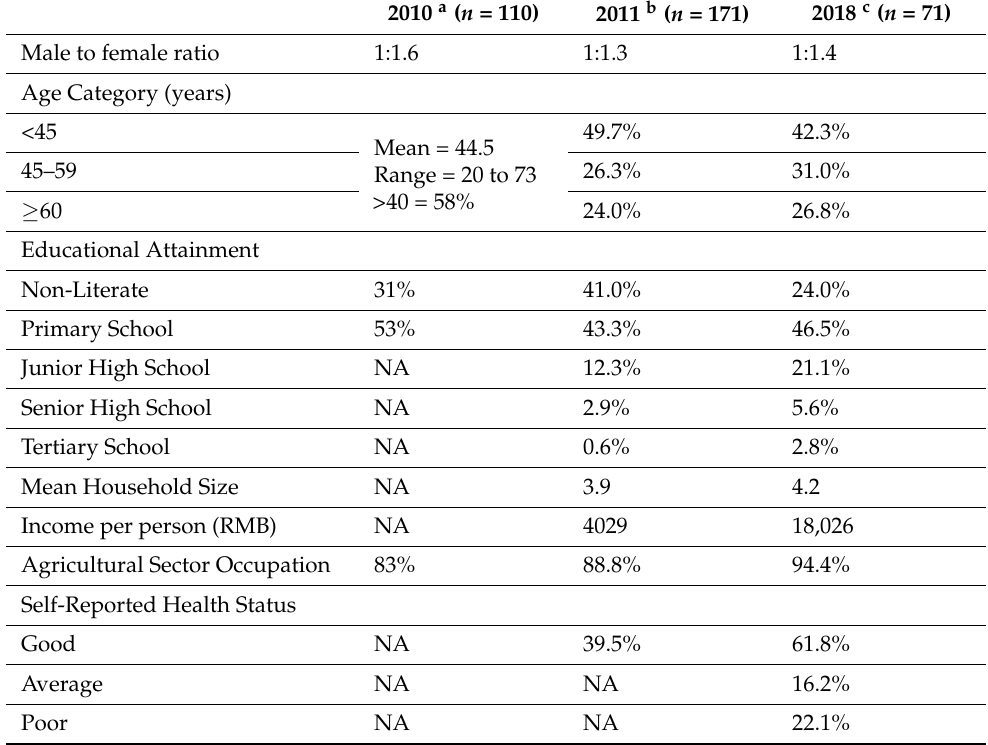
Table 2. Characteristics of Participants in the 2010, 2011 and 2018 Surveys in the Ma’an Qiao Village